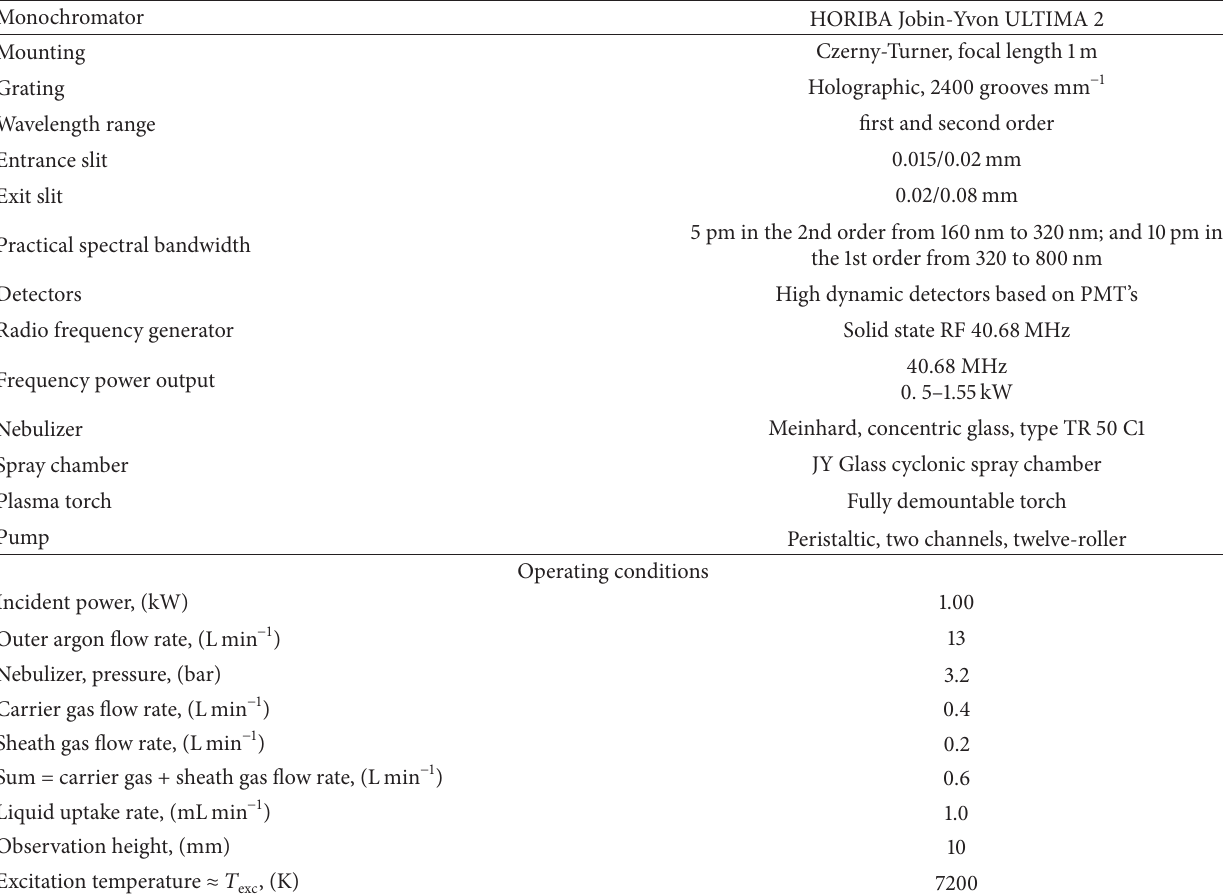
Table 1: Specification of ICP-OES spectrometer: HORIBA Jobin-Yvon ULTIMA 2 (France) and ICP operating